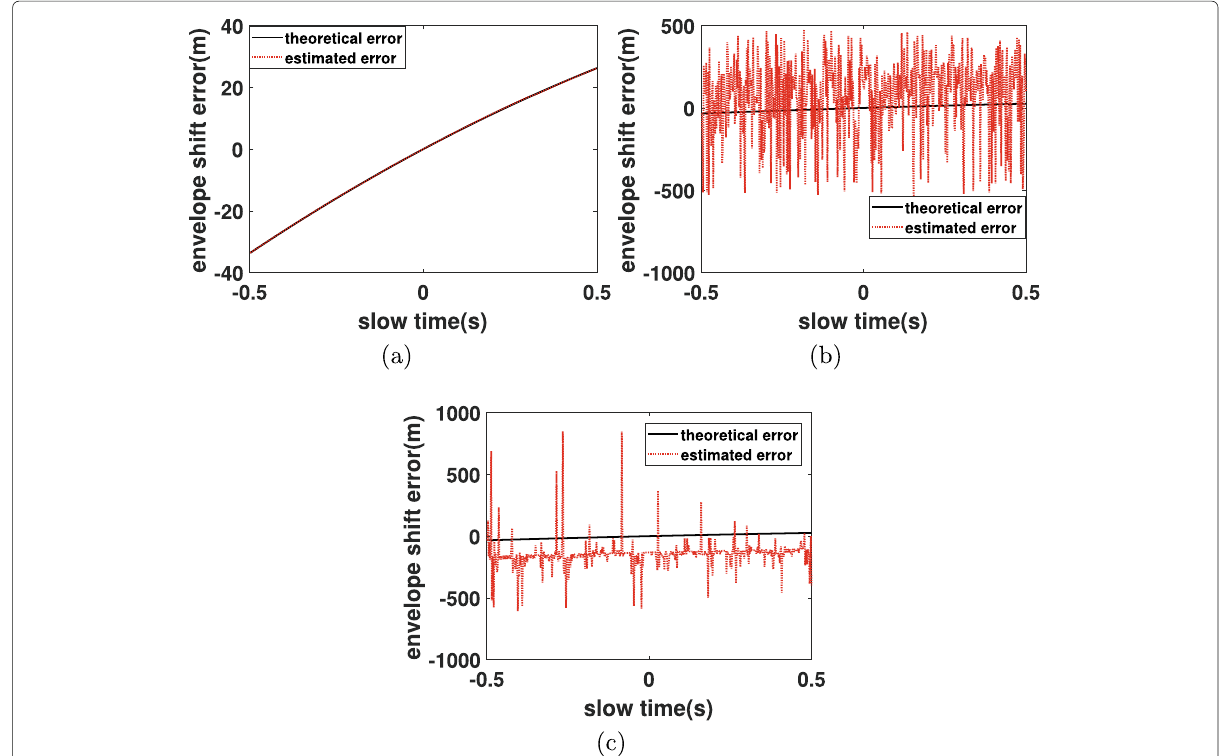
Fig. 8 Estimated error curves of the three methods under a − 15 dB SNR. a The estimated error curve of the proposed algorithm, b the estimated error curve of the ACM, and c the estimated error curve of the